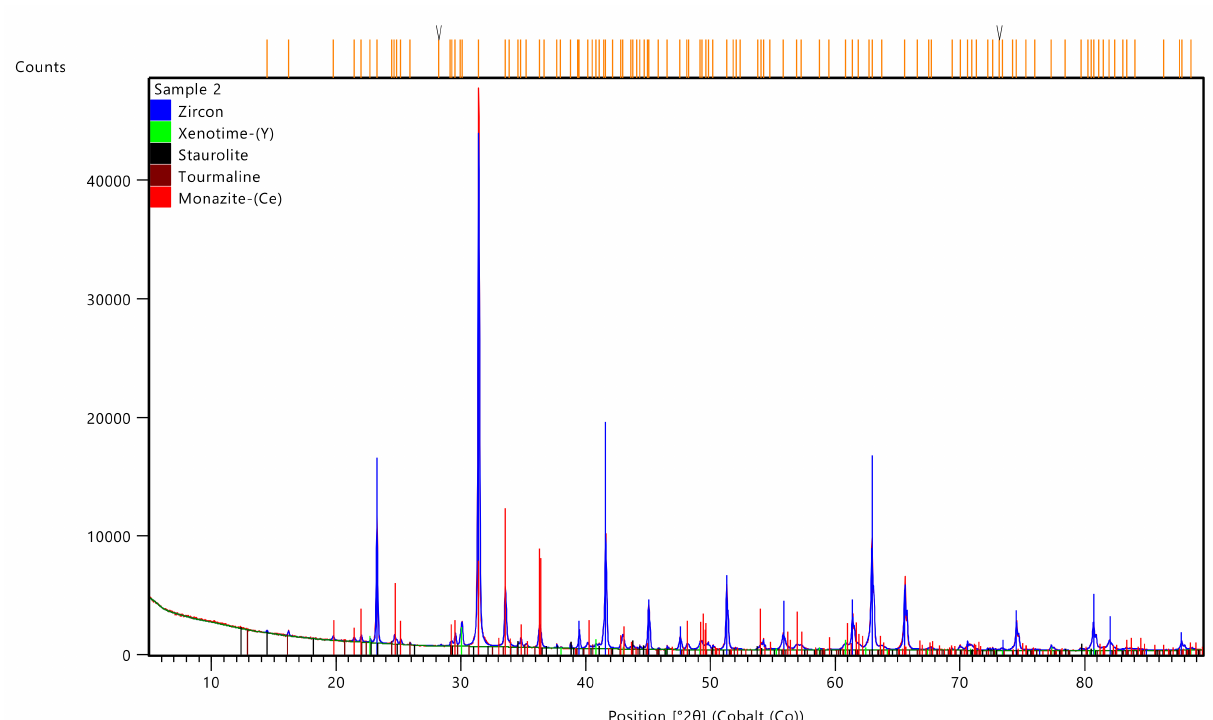
Figure 4. XRD diffractogram: Residue from 15 min leach, Perth monazite.